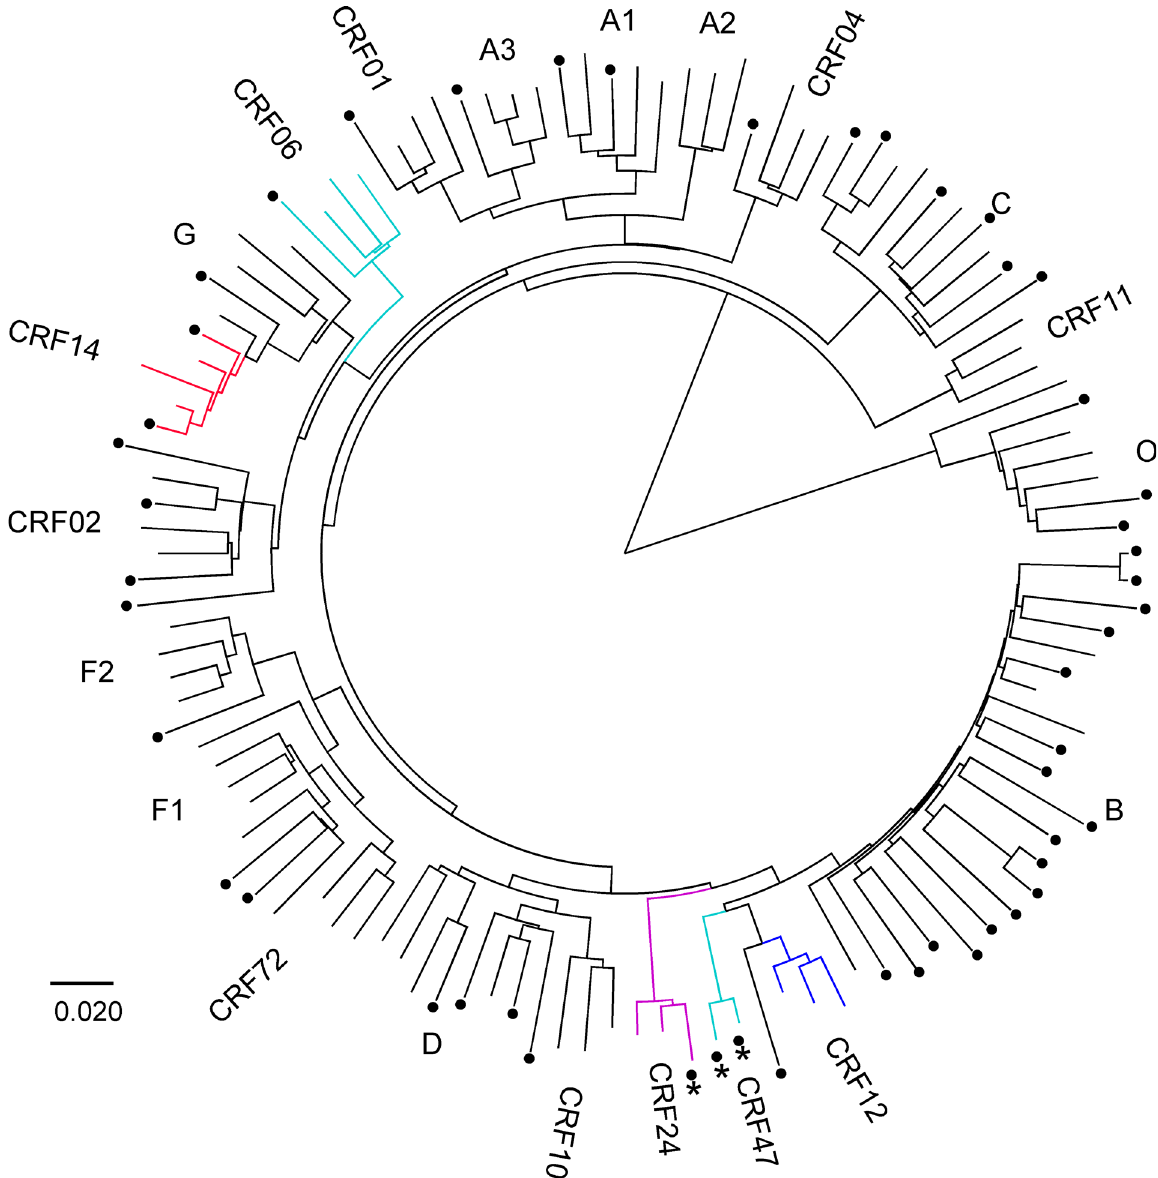
Fig 4. Phylogenetic clusters of CRF sequences. Partial pol gene sequences were aligned with all subtype references from the HIV sequence database. The phylogenetic tree was constructed using the neighbor-joining (NJ) method with Kimura two-parameter model. CRFs (06, 12, 14, 24 and 47) form distinct clusters and are depicted in different colors. The 50 sequences in the EQAPOL diversity panel are indicated by black dots. Asterisks indicate the EQAPOL sequences that are derived from the same strains used to define CRF24 and